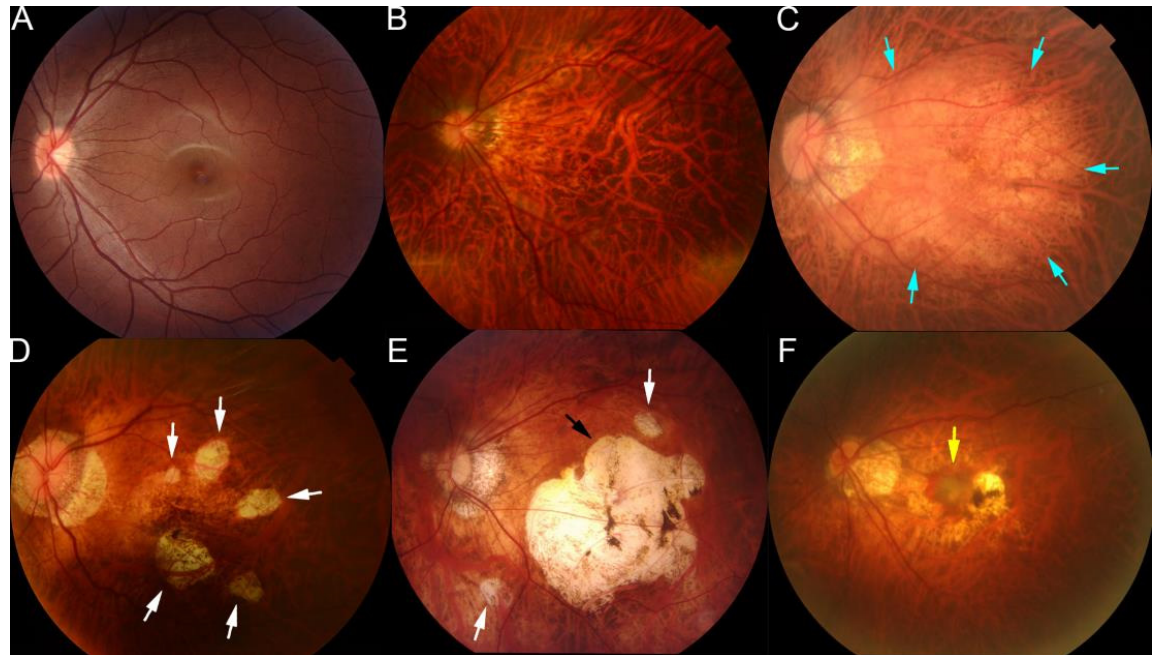
Figure 2. Representative fundus photographs showing the different types of lesions of maculopathy in eyes with pathologic myopia. ( A ) Normal fundus image. ( B ) Tessellated fundus. ( C ) Diffuse atrophy around optic disc and posterior fundus (blue arrows). ( D ) Patchy atrophy fundus (white arrows). ( E ) A fundus image from a left eye with macular atrophy at the center of posterior fundus (black arrow). Patchy atrophy (white arrow) as well as diffuse atrophy background can also be seen. ( F ) Fundus image with myopic choroidal neovascularization at the center of fundus (yellow arrow). Reprinted from Deep Learning Approach for Automated Detection of Myopic Maculopathy and Pathologic Myopia in Fundus Images , Vol 5, Pages No. 1235–1244, Copyright (2021), with permission from Elsevier.